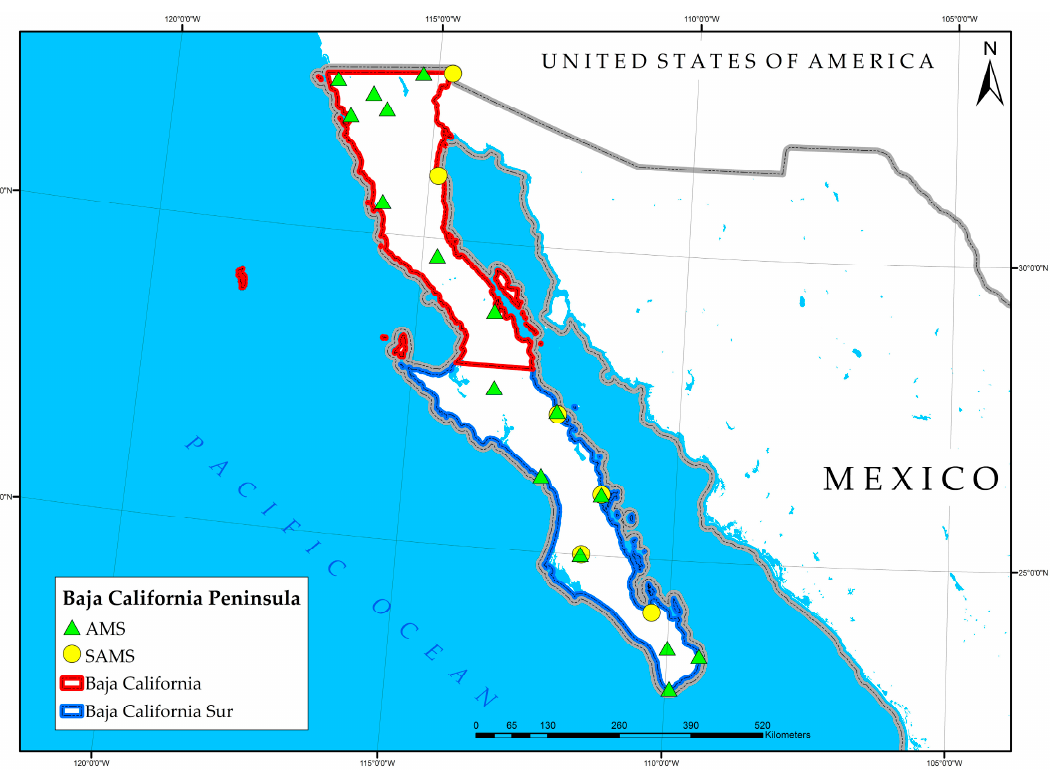
Figure 2. Baja California Peninsula. Table 1 lists the geographic positions of the AMSs and SAMSs. Table 1. Meteorological station coordinates along the Baja California Peninsula.